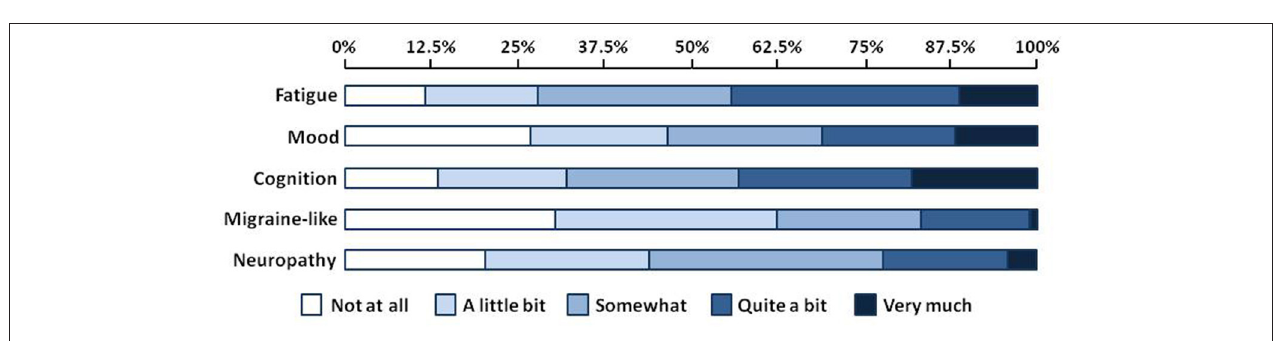
FIGURE 2 | % of patients reporting being bothered by symptoms in each symptoms